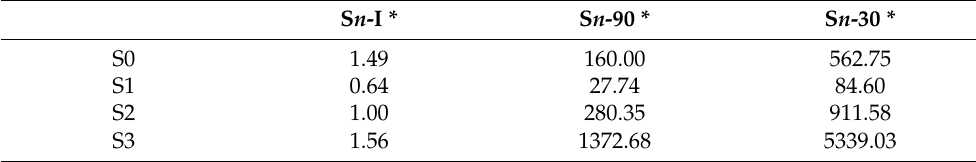
Table 2. Zero shear complex viscosity η *